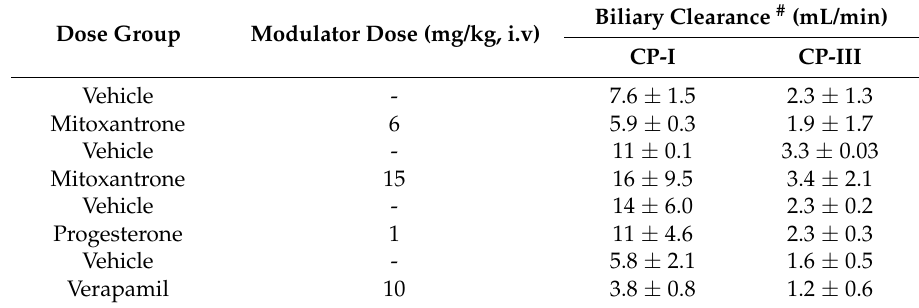
Table 1. Biliary clearances coproporphyrin-I (CP-I) and CP-III in male Sprague Dawley (SD) rats treated with vehicle or modulator.